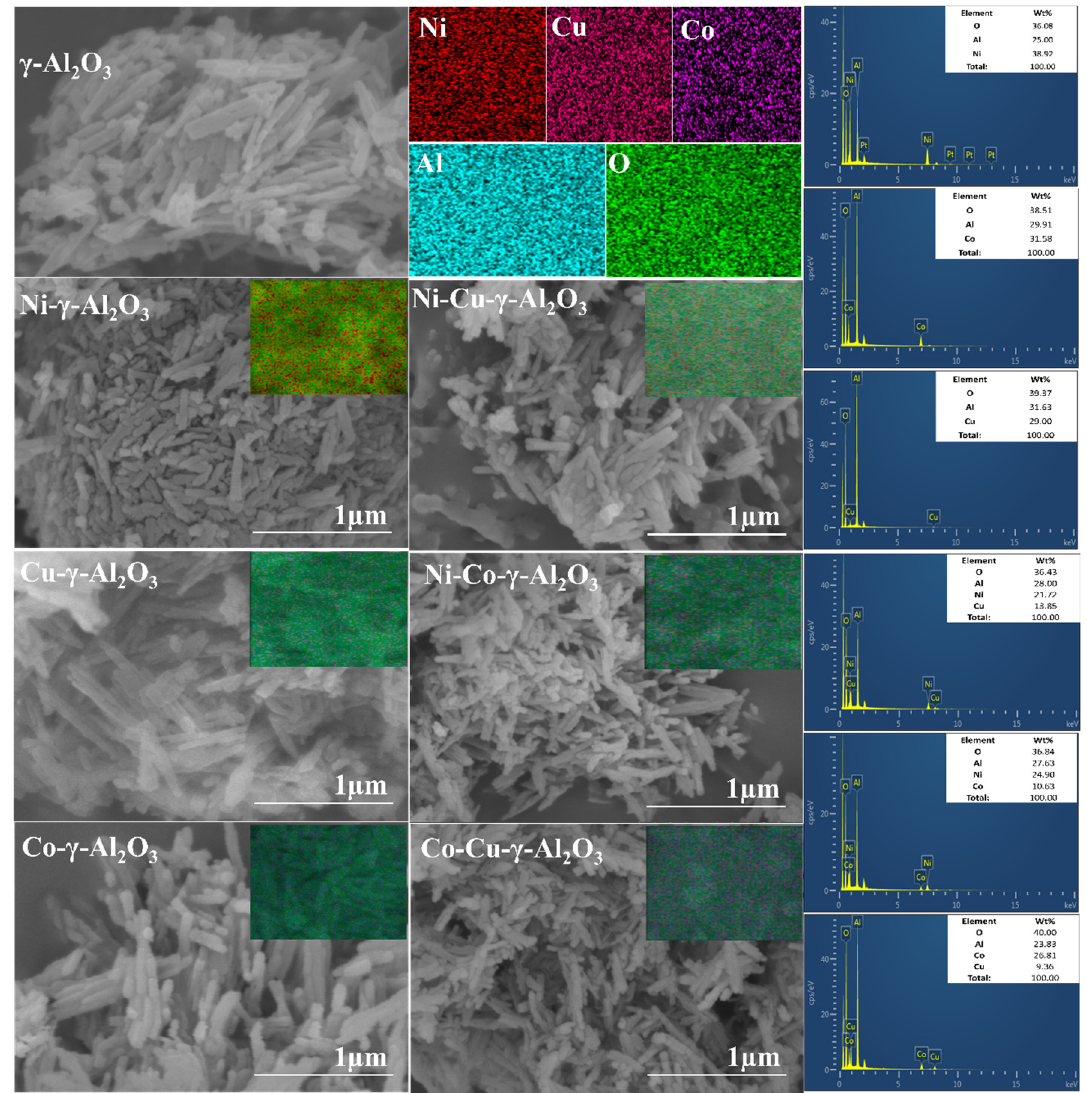
Figure 4. SEM images, elemental mapping and EDX patterns of the monometallic and bimetallic catalysts. Figure4. SEMimages, elementalmappingandEDXpatternsofthemonometallicandbimetalliccatalysts. XPS analysis was conducted for the selected catalysts after reduction to investigate the e ff ect of the addition of a second metal on the surface properties of the monometallic catalysts. The XPS results of the Ni 2p, Cu 2p, and Co 2p spectra are presented in Figure 6. Based on the deconvolution of Ni 2p spectra, the binding energies at 852.5 eV in the Ni 2p3 / 2 spectra of the reduced Ni / Al 2 O 3 catalyst is assigned to the metallic Ni. The XPS spectra of Ni / Al 2 O 3 also presented two peaks in the Ni 2p3 / 2 and Ni 2p1 / 2 spectra at about 855.4 eV and 873.8 eV with corresponding satellite peaks at 862.7 eV and + 880 eV, respectively, which are assigned the Ni 2 species [23]. Ni 0 binding energies in the Ni 2p3 / 2 spectra in the bimetallic catalysts Ni-Cu / Al 2 O 3 and Ni-Co / Al 2 O 3 are 853.3 eV and 853.7 eV,